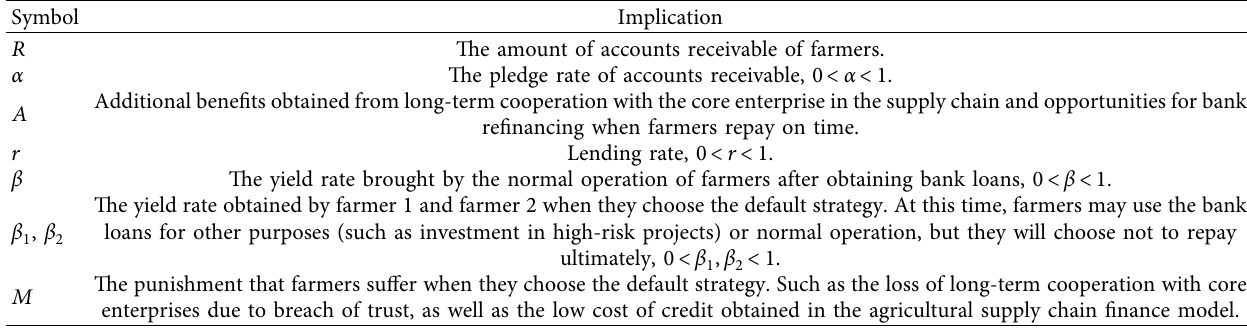
Table 1: Notation description.